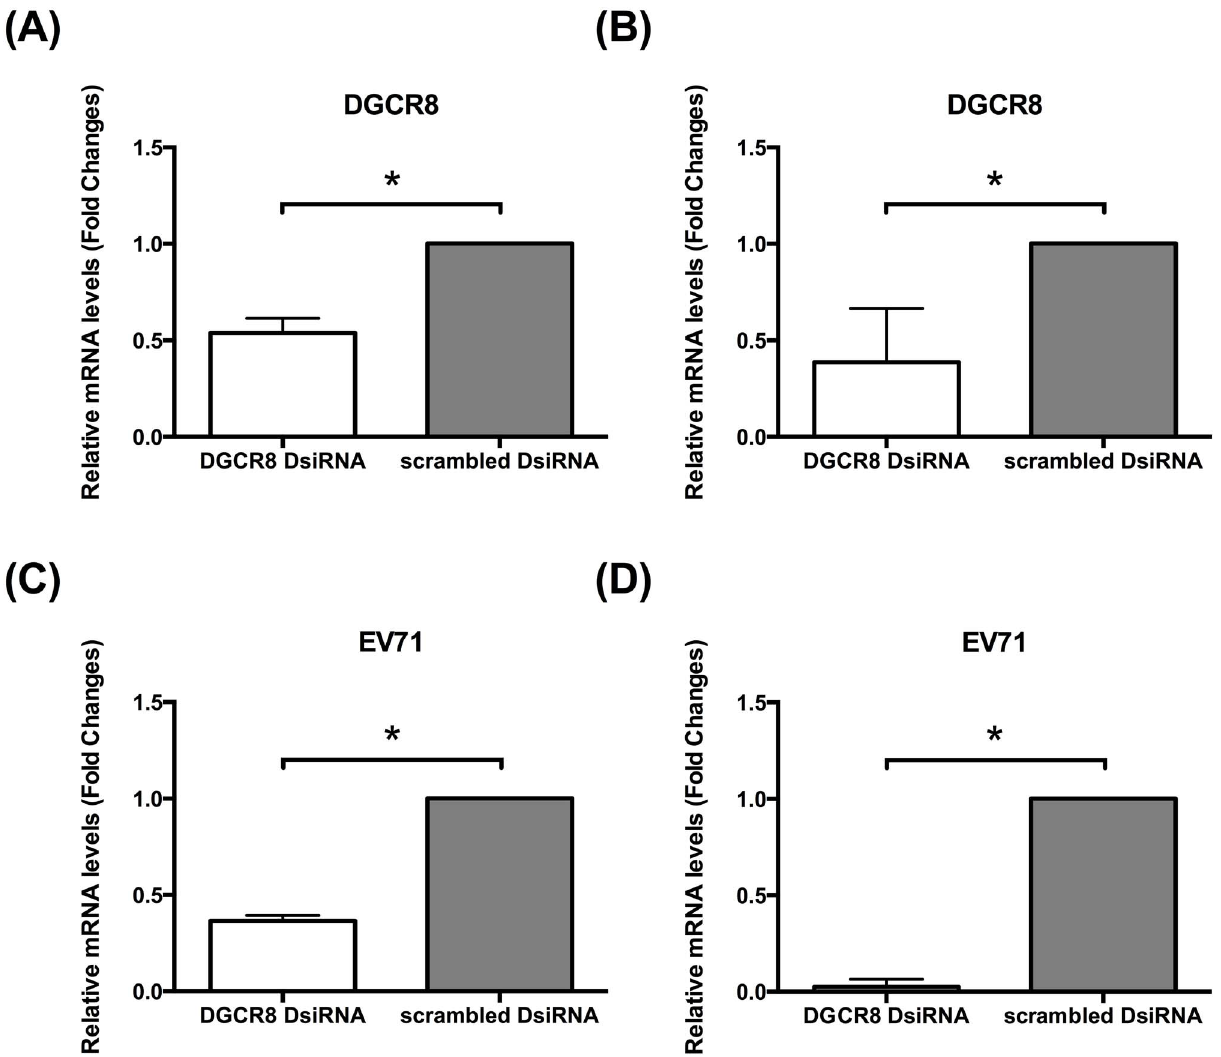
Figure 3. EV71 is unable to establish infection in both RKO and RD miRNAs depleted cells. DGCR8 knockdown cells and control cells (scrambled DsiRNA) in both RKO and RD cell line were infected with EV71 (MOI of 1). Total intracellular RNA were harvested at 12 hpi, converted to cDNA and measured by qPCR with primers specific to viral VP1. (A) Relative expression of DGCR8 gene in miRNAs depleted RKO cells measured by qPCR verifying knockdown. (n=3, *= p values of , 0.05) (B) Relative expression of DGCR8 gene in miRNAs depleted RD cells measured by qPCR verifying knockdown. (n=3, *= p values of , 0.05) (C) Relative expression of EV71 viral RNA in miRNAs depleted RKO cells measured by qPCR. (n=3, *= p values of , 0.05) (D) Relative expression of EV71 viral RNA in miRNAs depleted RKO cells measured by qPCR. (n=3, *= p values of ,